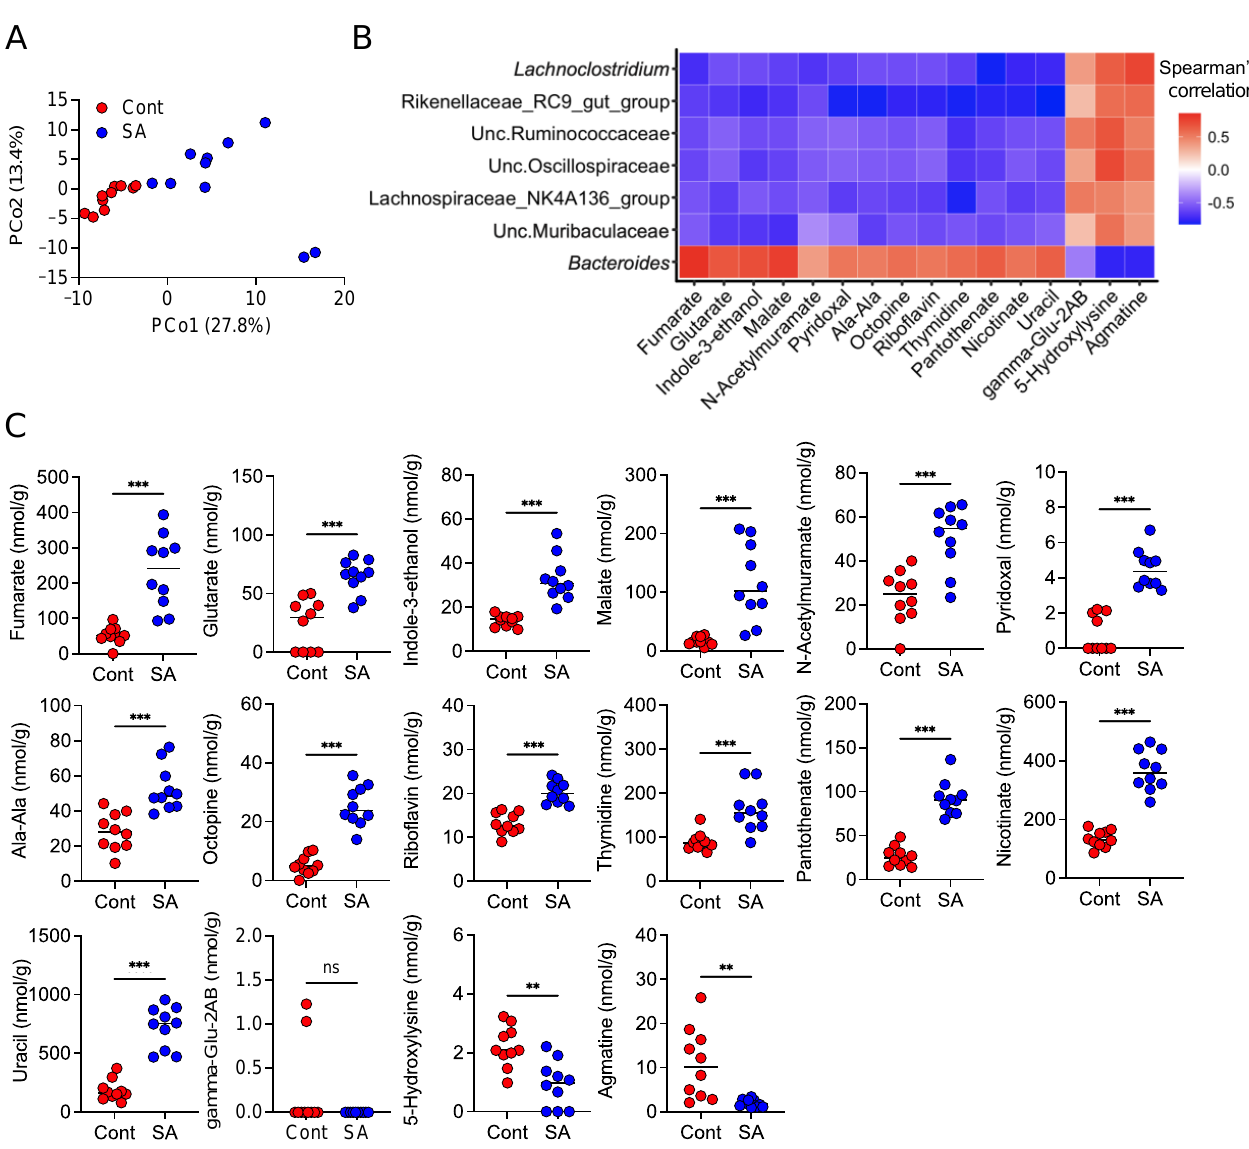
Figure 6. Dietary treatment with sodium alginate (SA) increased the levels of metabolites that correlated positively with the abundance of Bacteroides . Metabolites in mouse feces were analyzed by CE-TOFMS. Metabolome analyses were perFigure 4. weeks after feeding the mice HFD supplemented with or without 5% SA ( n = 10 mice per group). ( A ) PCoA for the fecal samples was performed using unweighted UniFrac. ( B ) Heat map shows correlations between gut bacteria abundance and levels of fecal metabolites by Spearman’s correlation analysis. Red and blue colors denote the positive and negative correlation values, respectively. ( C ) Measurement of the levels of metabolites in the feces of mice maintained on a HFD supplemented with or without 5% SA. Each dot represents an individual mouse, and the horizontal bars indicate mean values. Statistical significance in ( C ) was assessed by unpaired Student’s t -test for glutarate, N-acetylmurate, pyridoxal, Ala- Ala, riboflavin, and 5-hydroxylysine; Welch’s t -test for fumarate, indole-3-ethanol, malate, octopine, uracil, and agmatine; and Mann–Whitney U-test for thymidine, pantothenate, nicotinate, and gamma-Glu-2AB. ** p < 0.01; *** p < 0.001; n.s., not significant. Cont: HFD diet, SA: HFD diet with 5% sodium